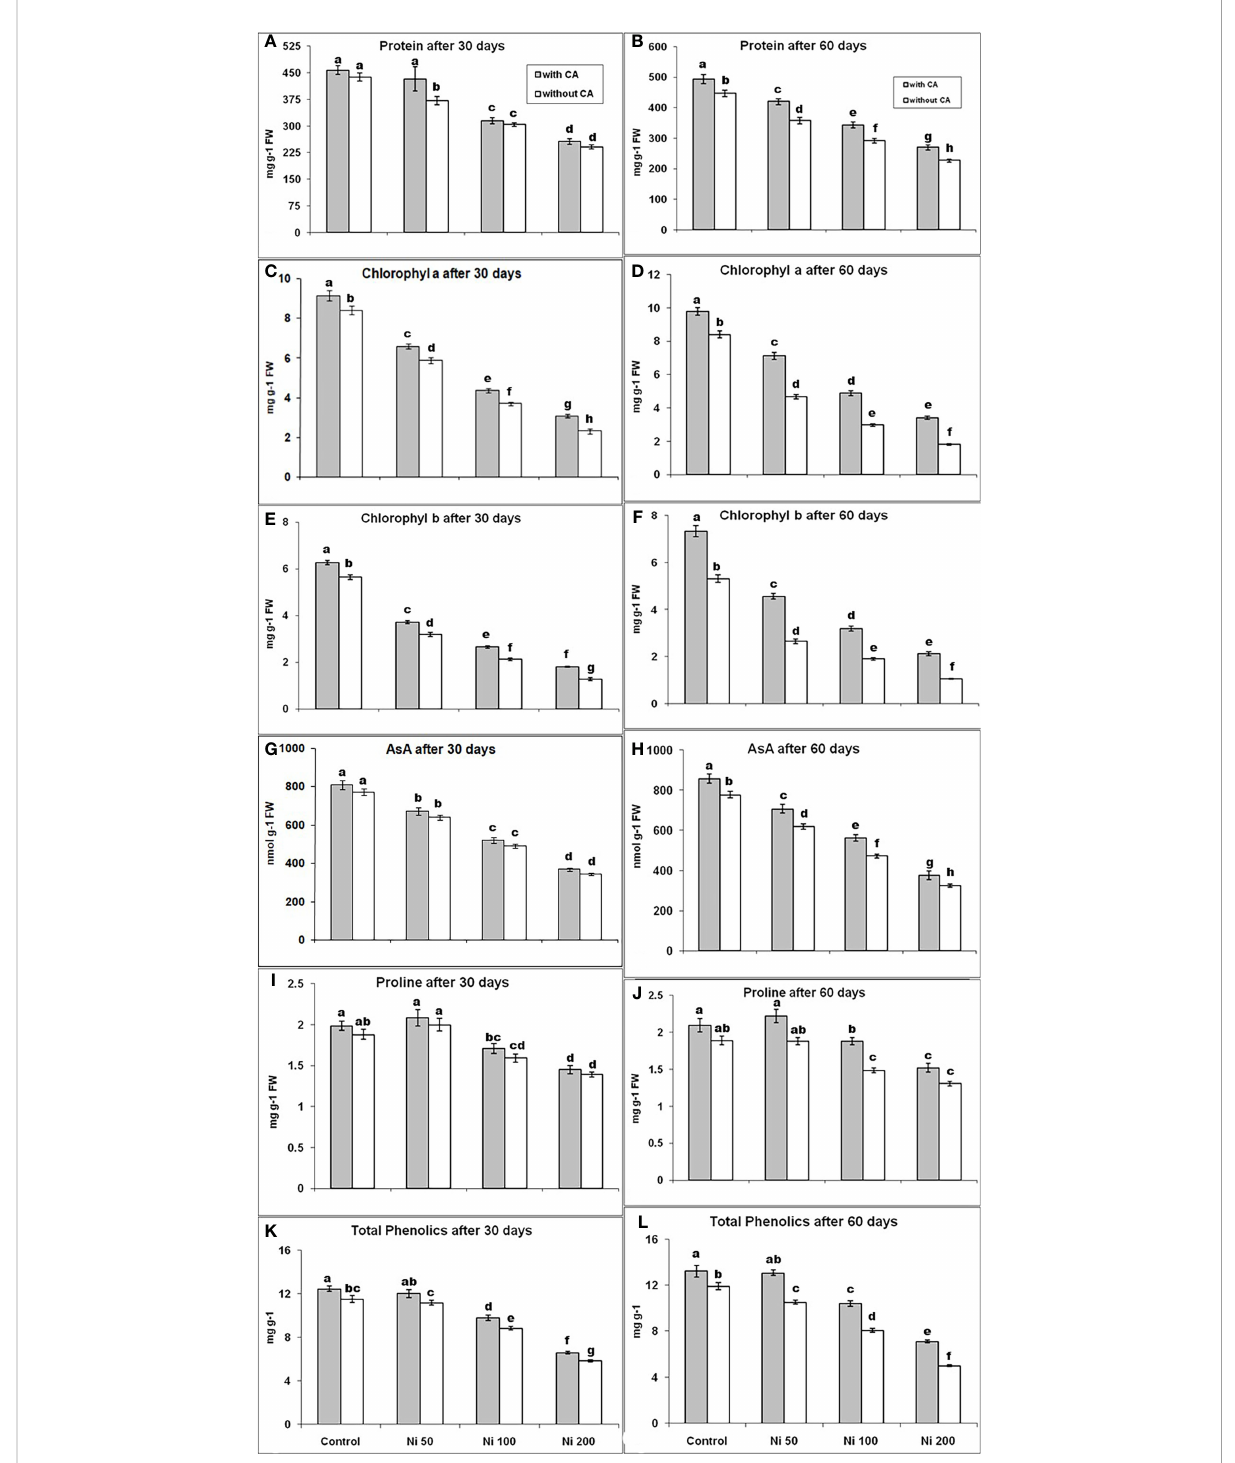
FIGURE 2 Protein content at 30 th day (A) , Protein content at 60 th day (B) , Chl a content at 30 th day (C) , Chl a content at 60 th day (D) , Chl b content at 30 th day (E) , Chl b content at 60 th day (F) , AsA content at 30 th day (G) , AsA content at 60 th day (H) , Proline content at 30 th day (I) , Proline content at 60 th day (J) , Total phenolics content at 30 th day (K) and Total phenolics content at 60 th day (L) , in sun fl ower plants. The bars designated with Ni 50, Ni 100, and Ni 200 represent Ni concentration at 50, 100, and 200ppm, respectively. “ With CA ” means these Ni-stressed plants are supplemented with 5 mM CA and vice versa for “ Without CA ” . The bars denoted by different letters are signi fi cantly variable at P ≤ 0.05 using the LSD